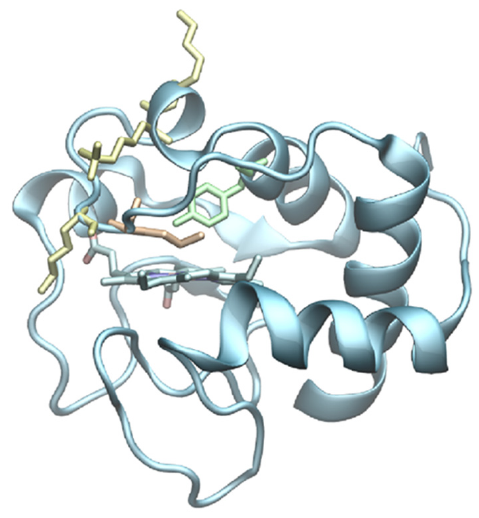
Figure 1. Cartoon representing the 3D structure of wild type yeast cytochrome c (PDB 2YCC) highlighting Met80 (orange), Tyr67 (light green), and Lys 72, Lys73, and Lys 79 (yellow).